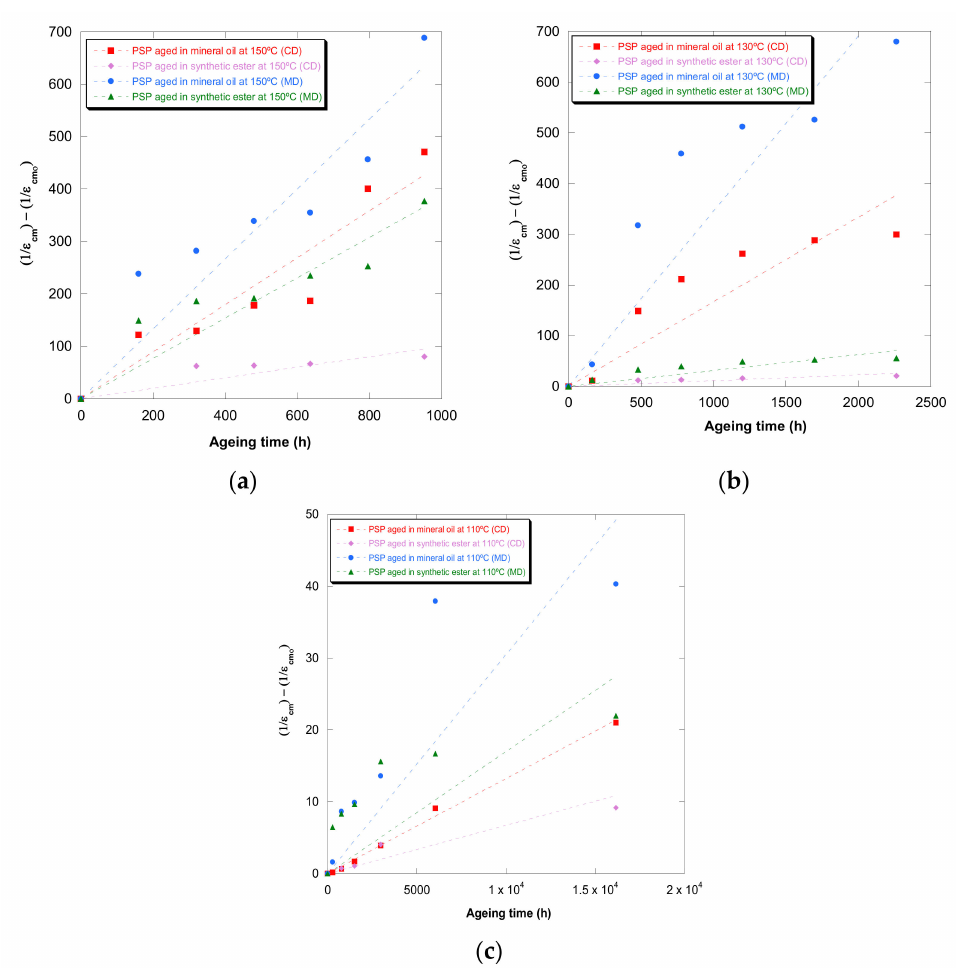
Figure 6. Evolution of the (1/ ε cm − 1/ ε cm0 ) in MD and CD as a function of temperature for pressboard PSP 3055 aged in mineral oil and in synthetic ester at 150 ◦ C ( a ), 130 ◦ C ( b ), and 110 ◦ C ( c ) and Ekenstam’s